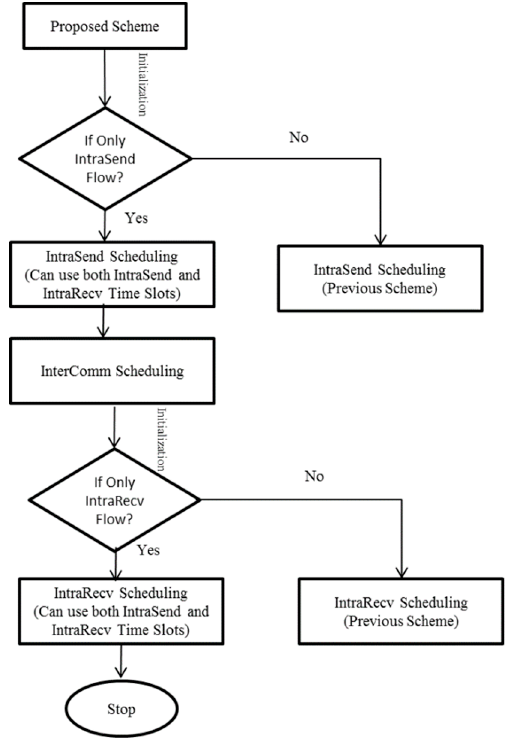
Figure 3. Flow diagram of proposed scheme.